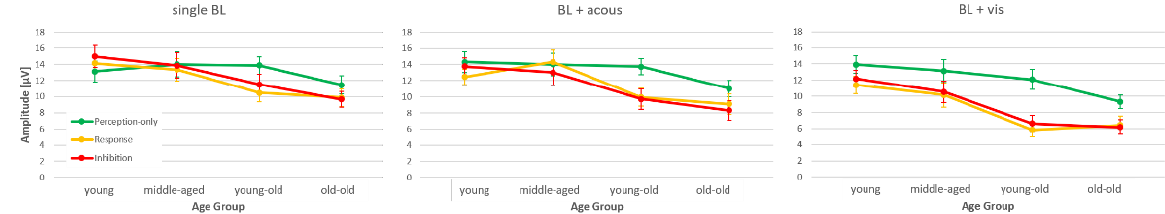
Figure 7. P3b-Amplitude in trials with single brake light (BL), brake light + acoustic stimulus (BL + acous) and brake light + visual stimulus (BL + vis) of the four age groups, presented separately for perception-only, response and inhibition task.